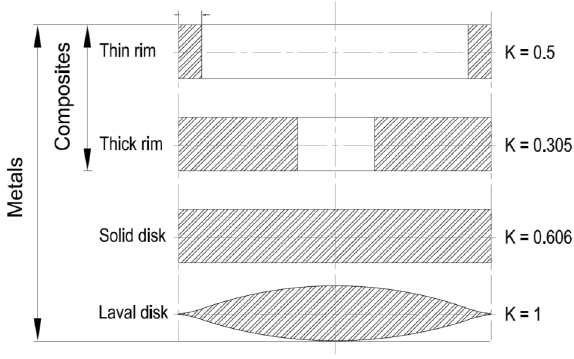
Figure 3 . Different flywheel cross sections [18].